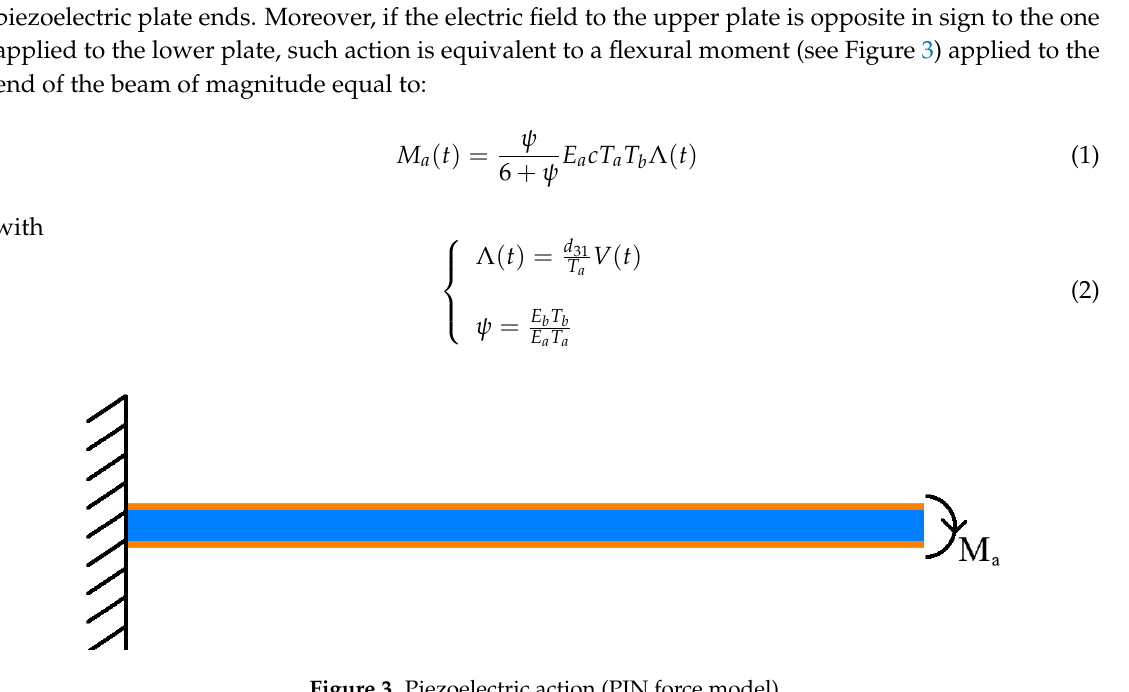
Figure 3. Piezoelectric action (PIN force